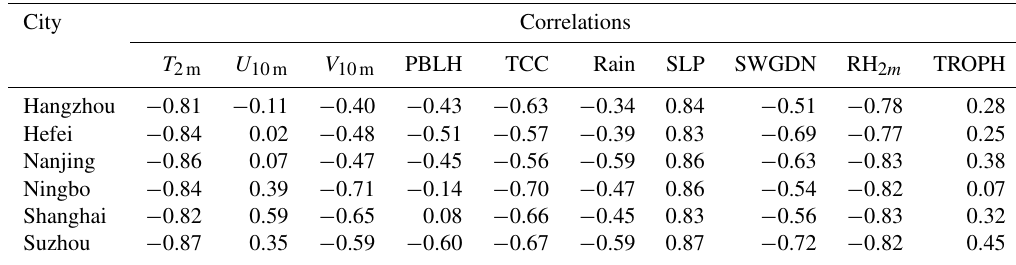
Table 5. Correlations of monthly averaged observations against each meteorological parameter from 2005–2020. City Correlations T 2m U 10m